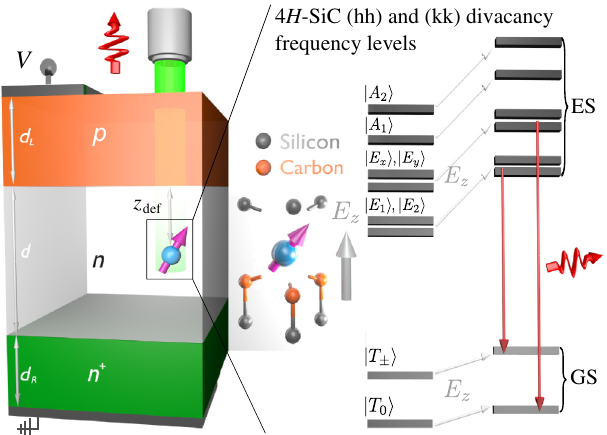
FIG. 1. The 4 H -SiC p - n - n + diode from Ref. [1] with one diva- cancy located in the n region at z = z def . The (hh) or (kk) diva- cancy lattice configuration is shown together with the response of its frequency to an applied electric field ( E z along the defect symmetry axis) produced by the diode voltage. The red arrows represent the PL transitions addressed in this